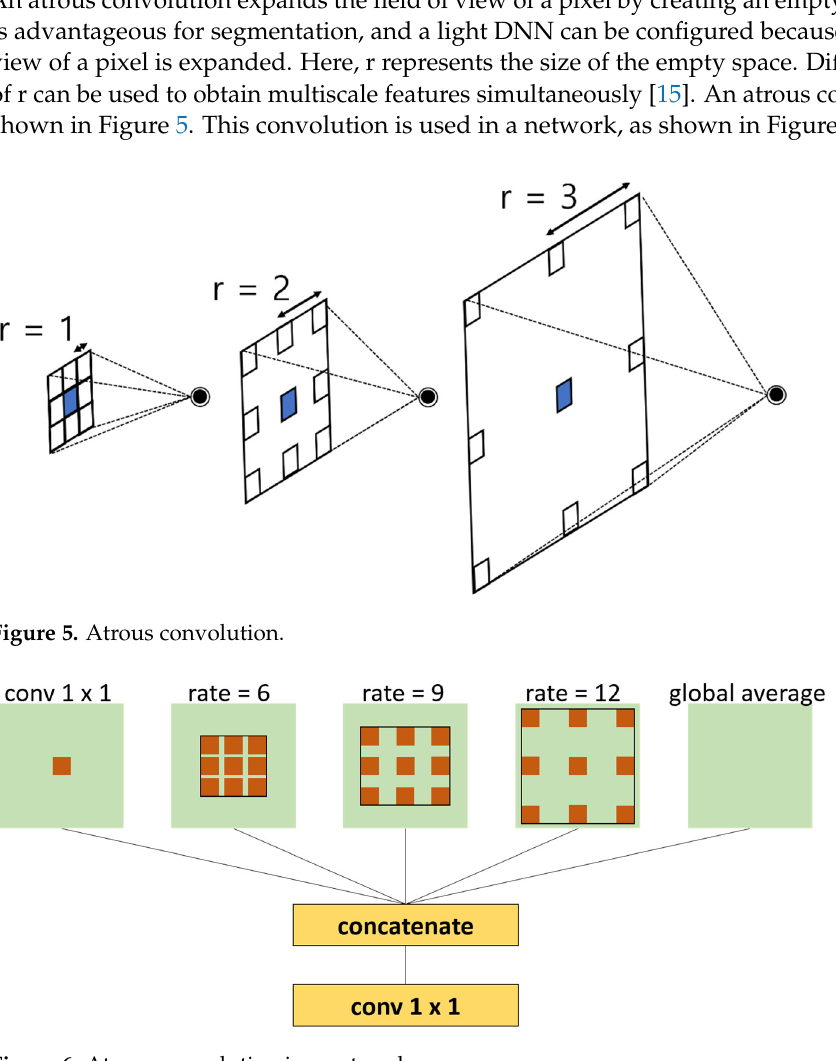
Figure 4. Semilocal convolution.